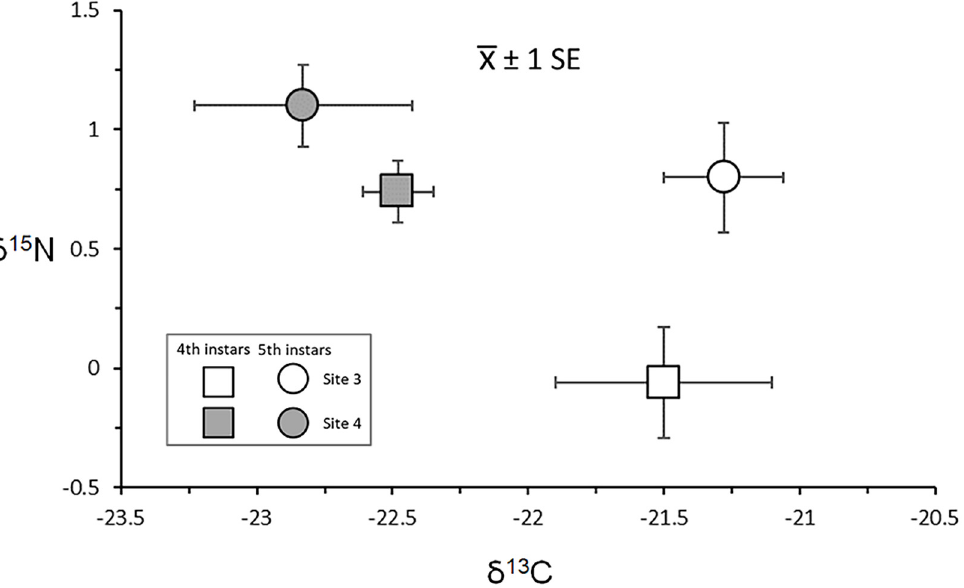
Figure 11. δ 13 C and δ 15 N means and standard errors for 4th and 5th instar larvae from Sites 3 and 4. Table 4. Tukey–Kramer post-hoc contrasts, means, and p -values for analyses of δ 13 C and δ 15 N values from 4th and 5th instar larvae collected from Sites 3 and 4. Significant p -values are highlighted in bold